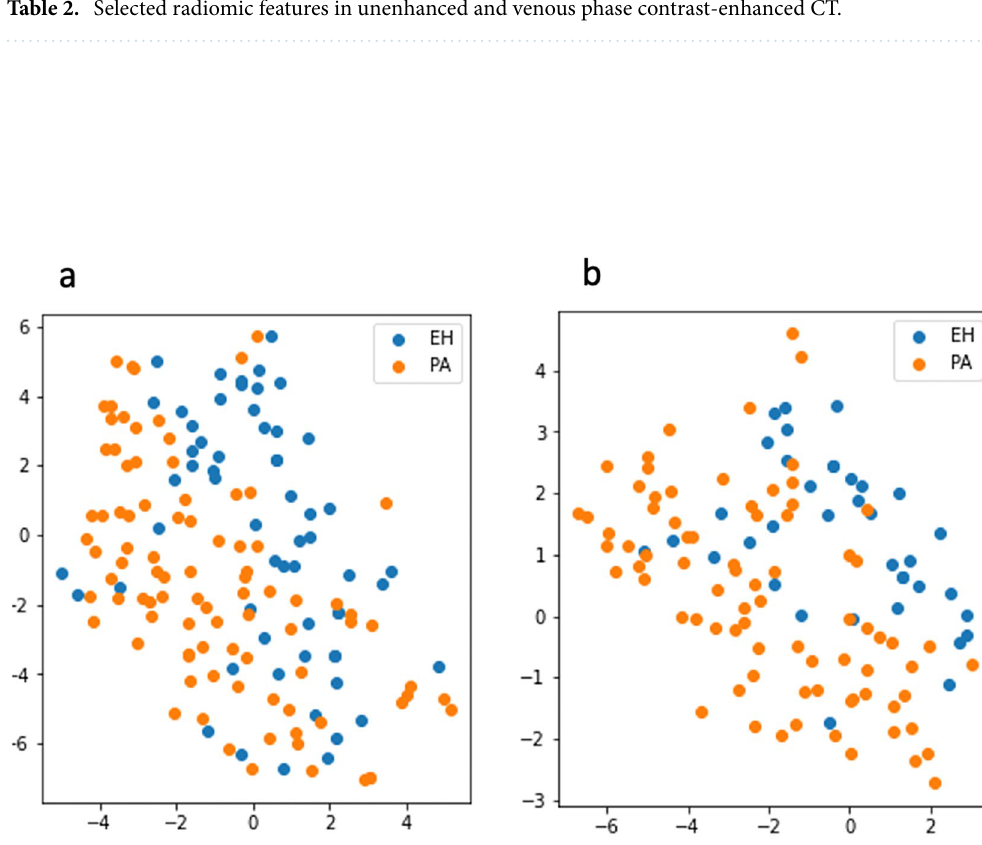
Figure 1. Separation of adrenal nodules in patients with PA and EH by t-distributed stochastic neighbor embedding (t-SNE). A two-dimensional scatter plot via t-SNE visualization (perplexity = 50) was based on the features selected in unenhanced CT ( a ) and venous phase CT ( b